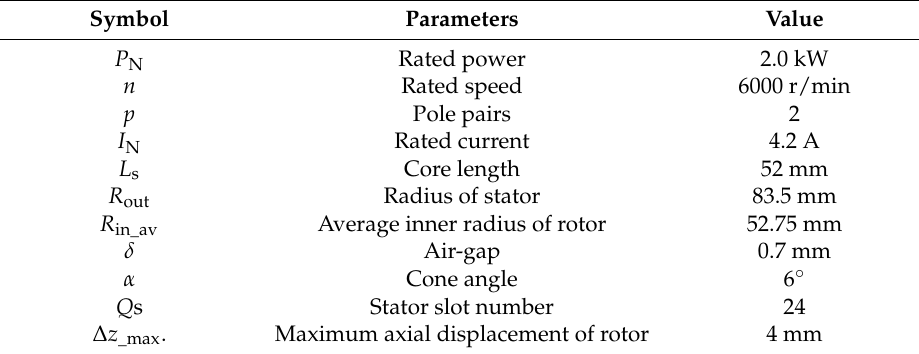
Table 1. Design parameters of the 2.0 kW conical-rotor permanent magnet synchronous motor (CR-PMSM). Symbol